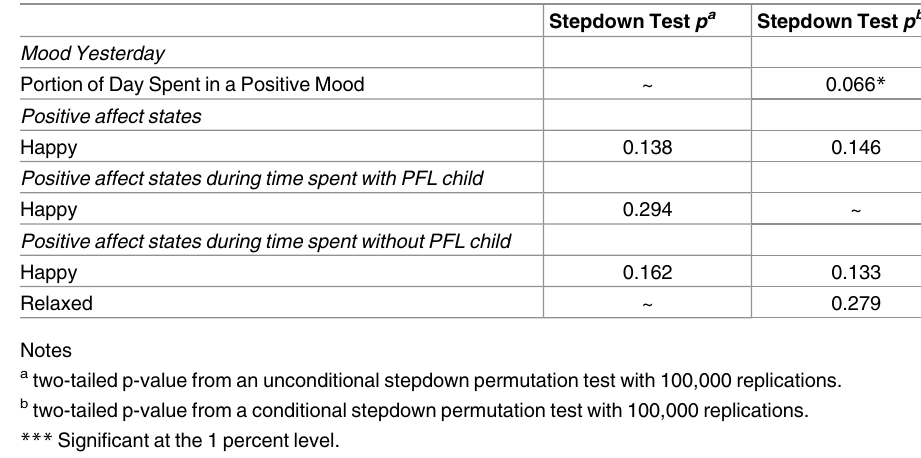
Table 5. Stepdown